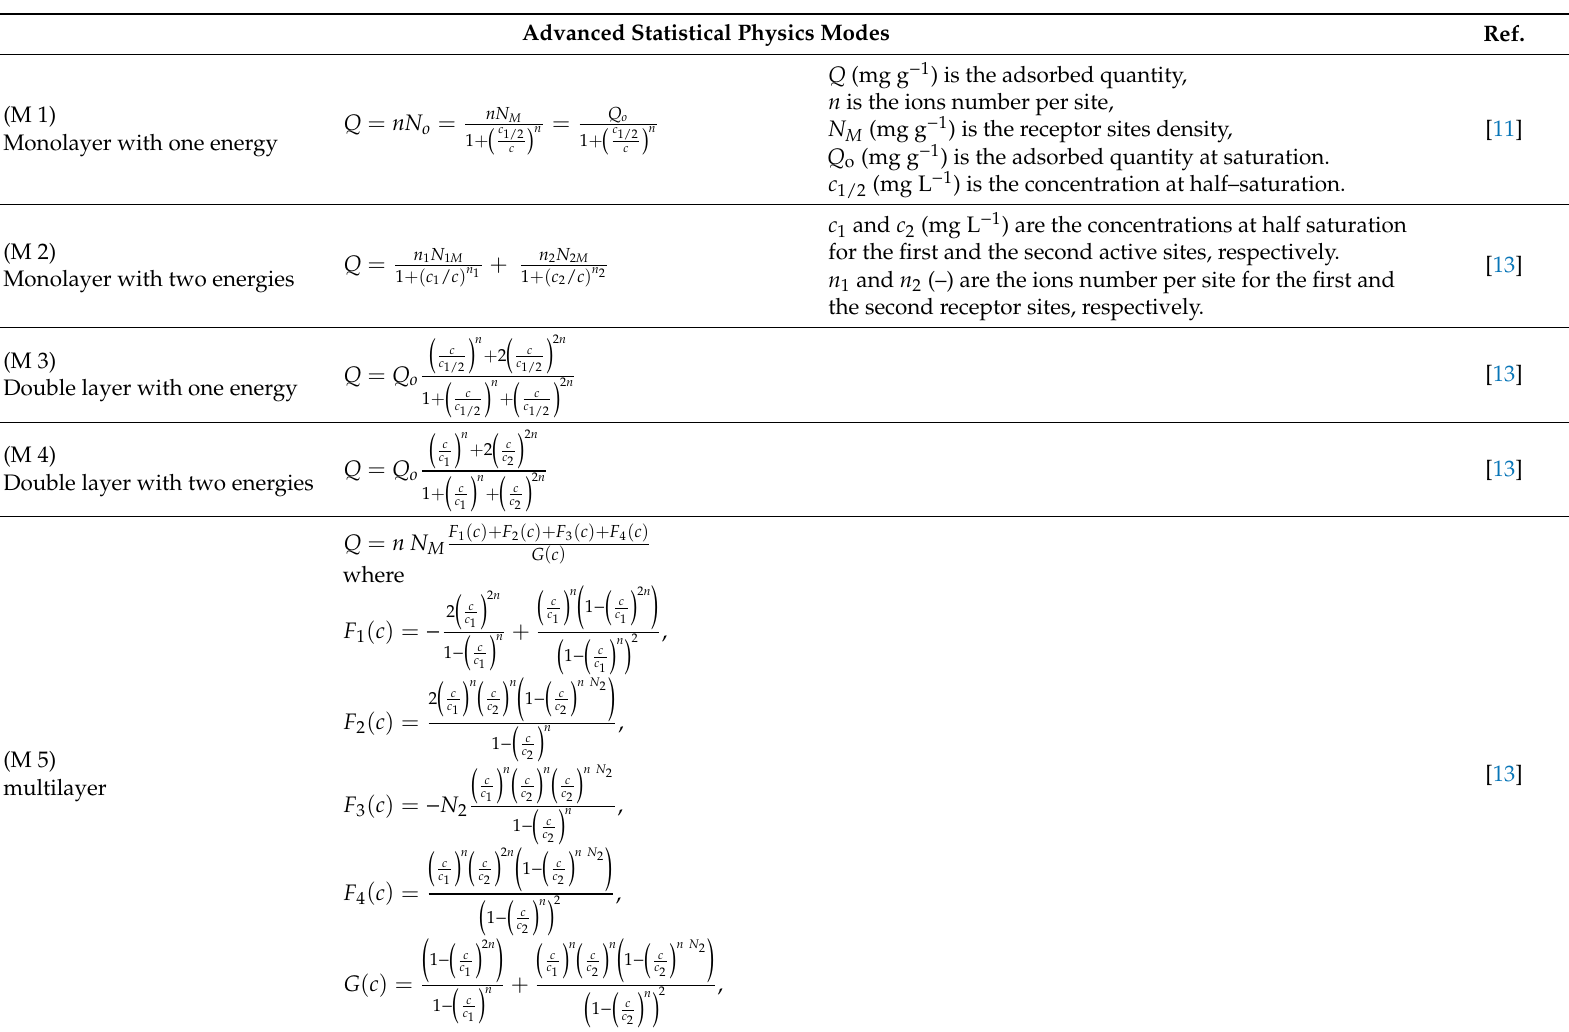
Table 2. Advanced statistical physics models to analyze the adsorption of CV on MNP / CTAB-EC